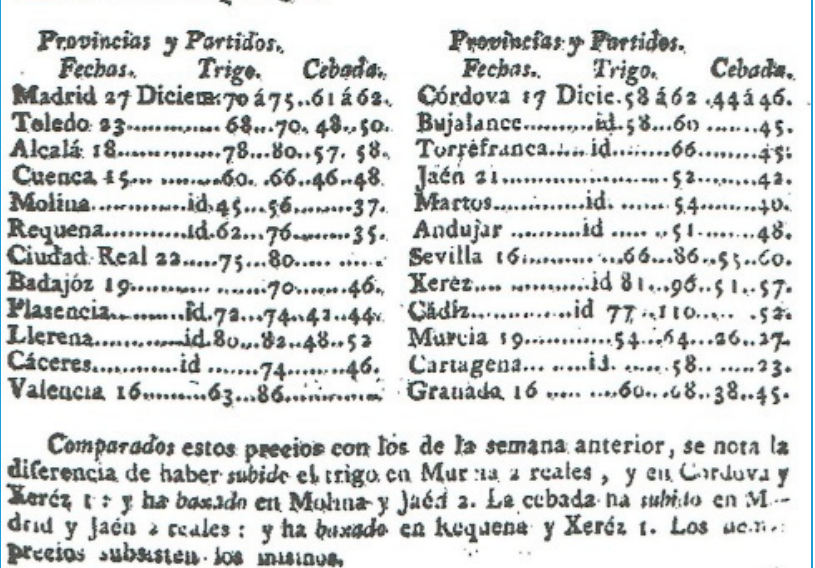
Figure 1. Front page of issue 104 (28/12/1797) of Correo Mercantil de España y sus Indias (CMEI).